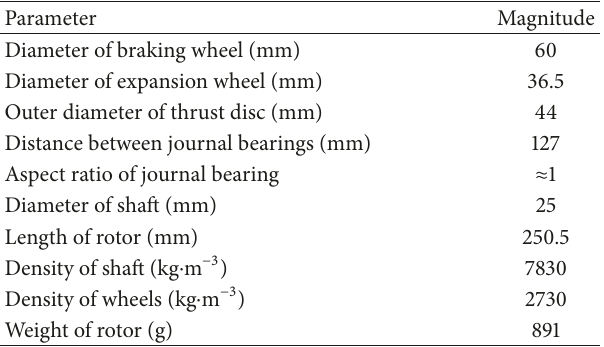
Figure 1: Assembly drawing of turboexpander for 150m 3 ⋅ h −1 air separation system. Table 1: Geometrical parameters of the